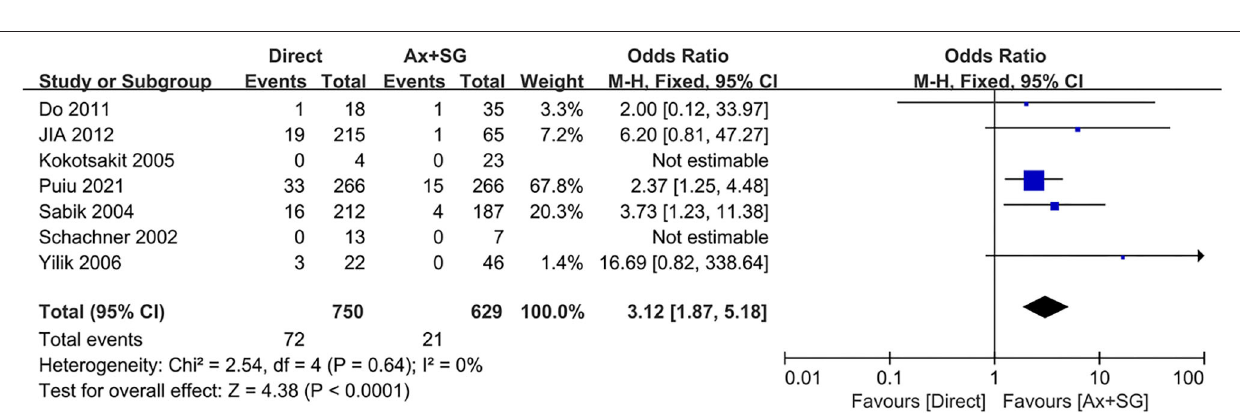
FIGURE 3 | Cannulation-related complication in direct artery cannulation vs. side-graft artery